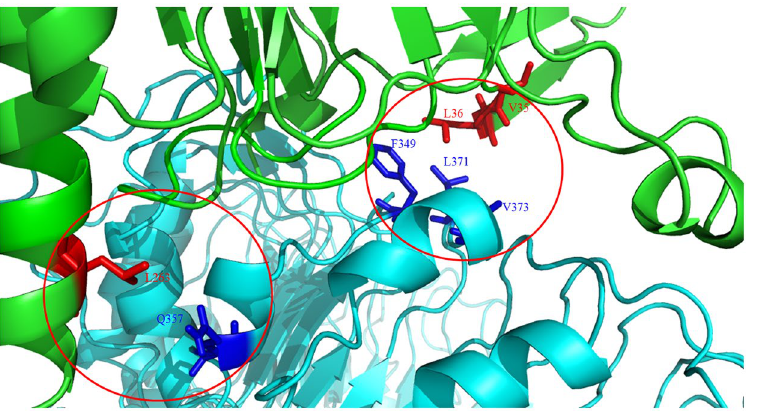
Figure 7. The proposed interaction interface of LipL32-TLR2 complex. The protein docking prediction of LipL32-TLR2 complex shows the N- and C-termini of LipL32 play vital roles of complex formation. The proposed binding interface of the LipL32-TLR2 complex indicates the residues of the LipL32 involving in complex formation (red color) and the predicted nearest distance to residues of TLR2 (blue color). Green, LipL32; cyan,